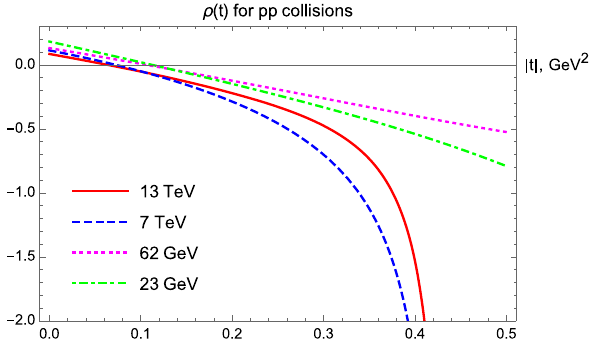
Fig. 18 The nuclear phase φ( t ) , shown in units of π as a function of the four-momentum transfer squared | t | , for pp collisions at TeV and 7 TeV, as compared to the nuclear phase for p ¯ p collisions at √ s = 1 . 96 TeV. Here, for illustration we also kept the corresponding principal values for the nuclear phase satisfying 0 < φ 2 ( t ) < π , also showninunitsof π .Thelatterareindicatedbythinneranddiscontinuous curves explicitly seen at large | t | > | t